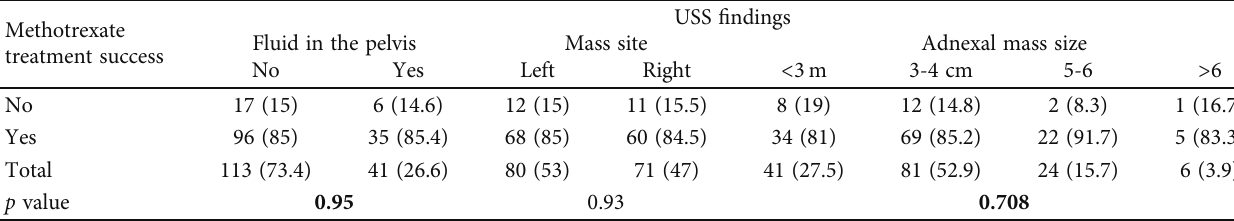
Table 3: Association of USS fi ndings and treatment success.